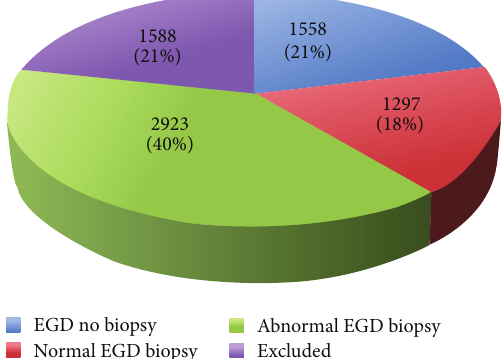
Figure 1: All EGDs performed at LHSC and SJHC between May 2012andApril2013.ExcludedEGDsincludedpatientsthathadmore than one EGD within the year or missing clinical, procedural, or pathological